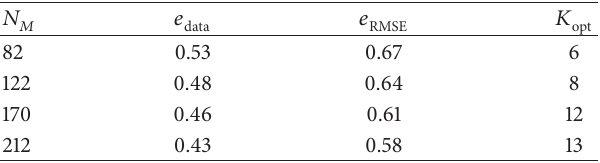
Table 3: Error measures for different values of the number of measurement points. Homogeneous dielectric cube.